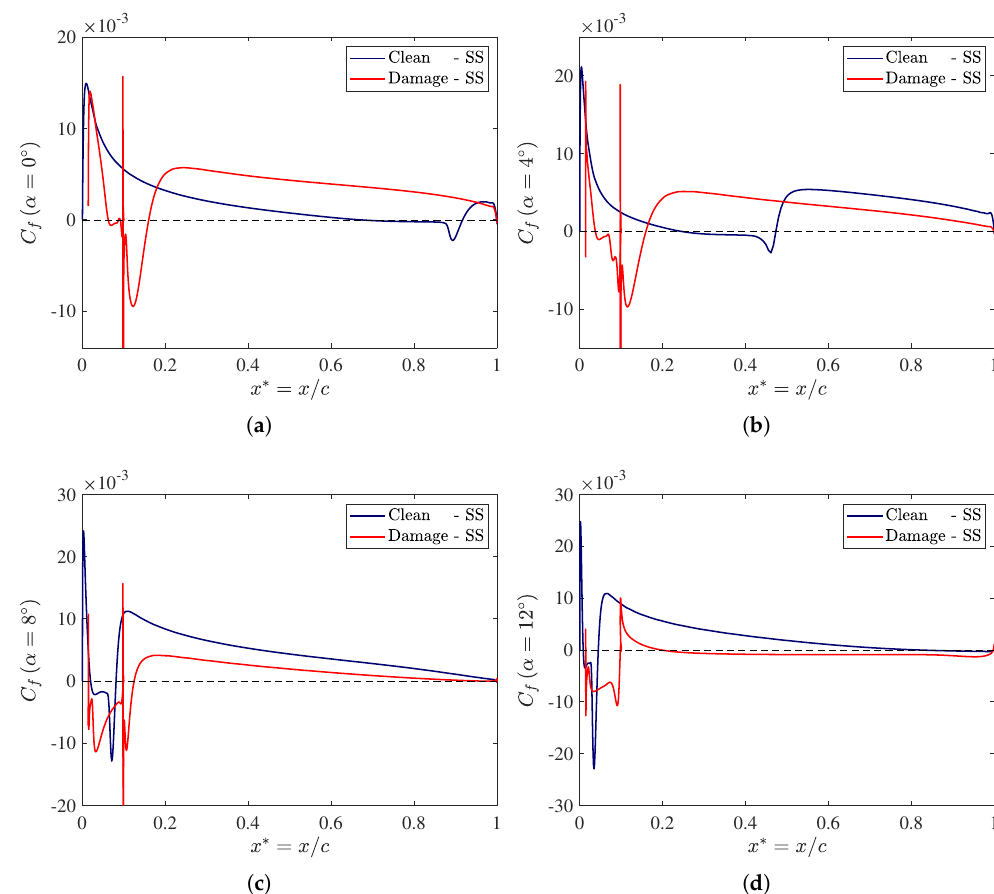
Figure 15. Friction coefficients comparison between the clean airfoil and the damaged airfoil. C f distribution at ( a ) 0 ◦ incidence; ( b ) 4 ◦ incidence; ( c ) 8 ◦ incidence; ( d ) 12 ◦